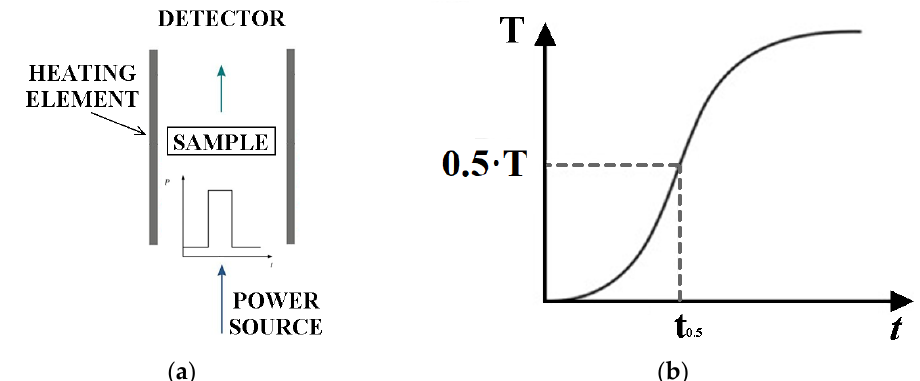
Figure 2. LFA method: ( a ) configuration of test; ( b ) calculation of parameters.